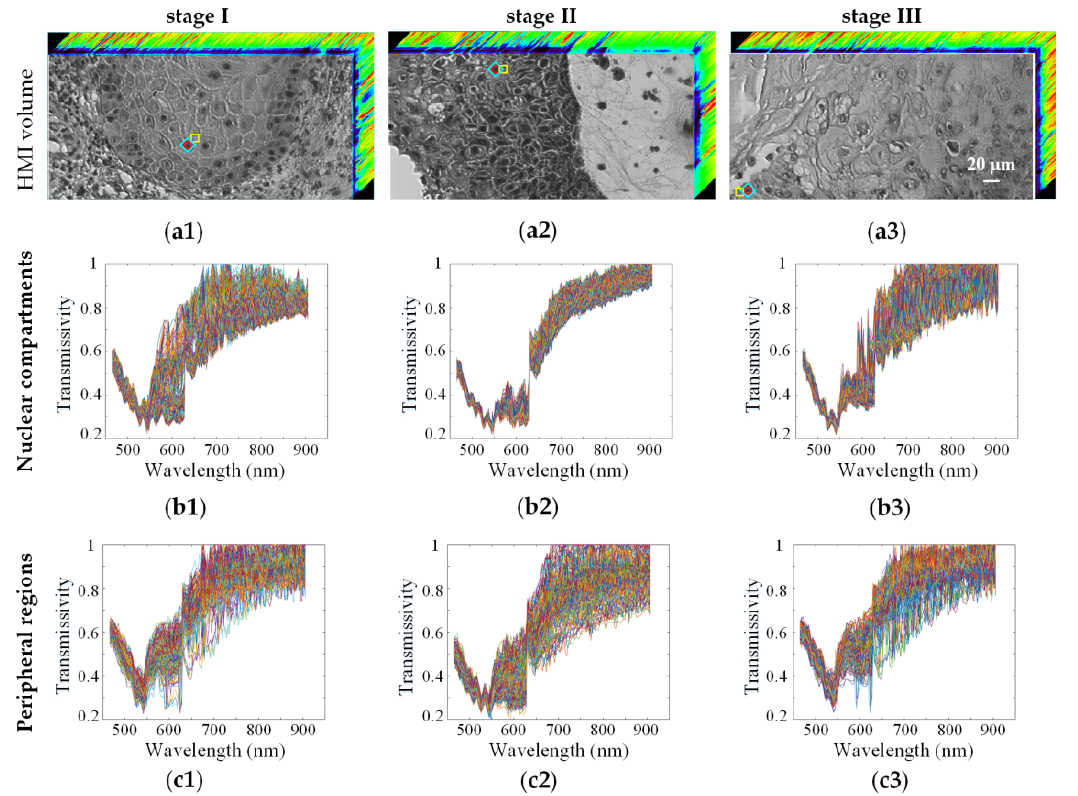
Figure 5. HMI images and original spectra of SCC at different clinical stages: stage I, stage II and stage III, respectively. ( a1 – a3 ) 3D HMI images. “ ◇ ”, “ ○ ” and “ □ ” represented the selected spectral ROIs including the nucleus and surrounding areas, the nuclear compartments, and the peripheral regions, respectively; ( b1 – b3 ) original spectra of the nuclear compartments; ( c1 – c3 ) original spectra of the peripheral regions. The different color lines represented the spectra of different sample pixels of the ROIs.